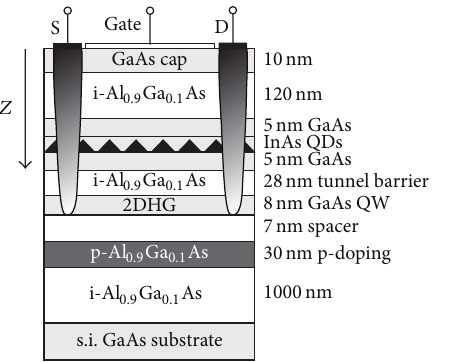
Figure 1: Schematic of the QD-based memory structure: A layer of QDs is embedded into a MODFET structure. The QDs and the 2DHG are separated by a 28-nm-wide tunnel barrier (consisting of 15nm Al 0.9 Ga 0.1 As and 8 nm GaAs). Figure 2: Valence band structure of the device. The InAs QDs inside the GaAs QW have a total localization energy of about 700meV, which can be estimated from a previous work [13] and from the valence band offset between GaAs and Al 0.9 Ga 0.1 As (500meV) [14].